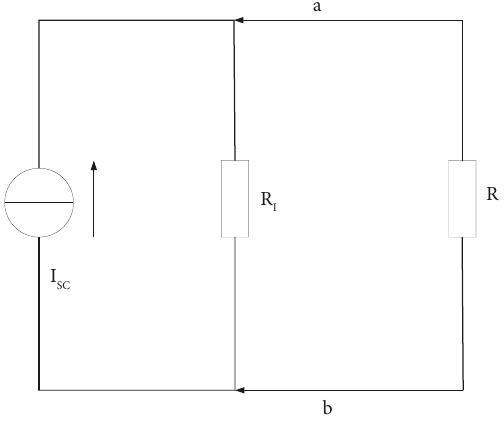
Figure 5: Norton-equivalent